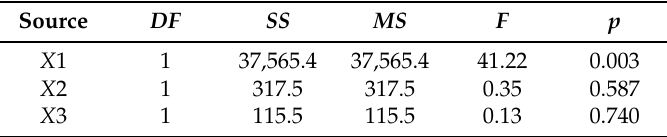
Table 11. ANOVA results with only main factors in the FTP-75 mode.